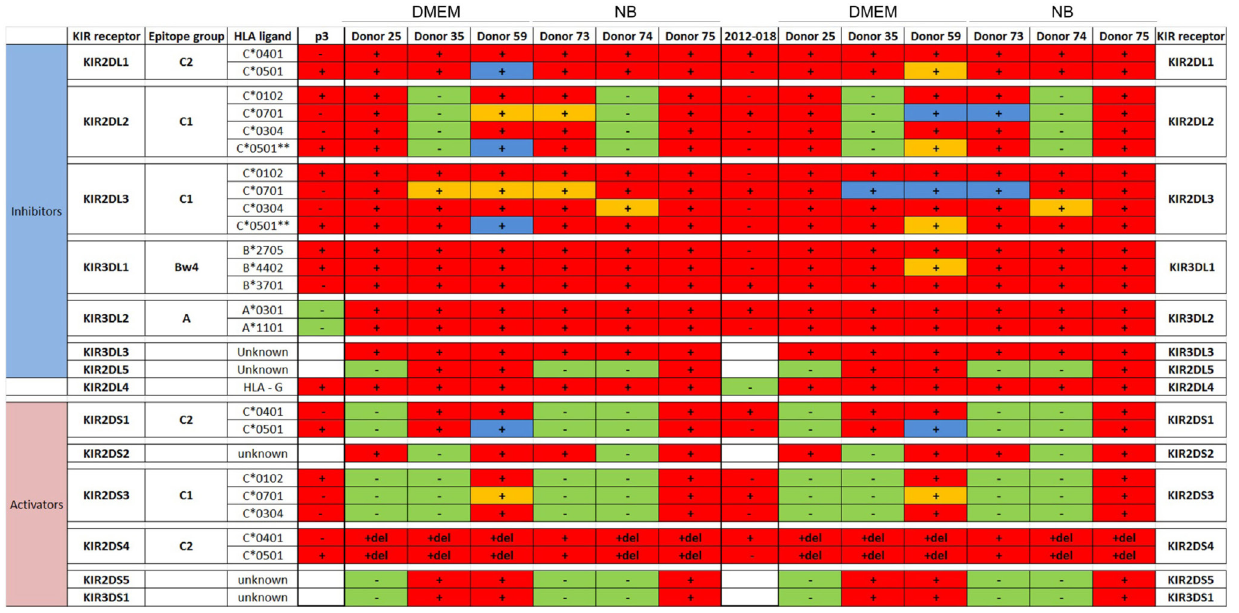
For natural killer (NK) cells: − and green, NK cells are negative for KIR; + and red, NK cells are positive for KIR; + del and red, NK cells have partial deletion KIR2DS4; + and blue, NK cells have been educated in the context of the cognate HLA, which is present in the glioblastoma (GBM); and + and orange, NK cells have been educated in the context of the cognate HLA, which is missing in the GBM, indicating a potential functional mismatch of inhibitory KIRs. For GBM: + , GBM are positive for the specific HLA ligand; − , GBM are negative for the HLA ligand. Red, GBMs are positive for at least one of the HLA ligands of the cognate KIR; green, GBMs are negative for all HLA ligands of the cognate KIR; and white, HLA ligand is unknown. **C2 epitope recognized by KIR2DL2/3.